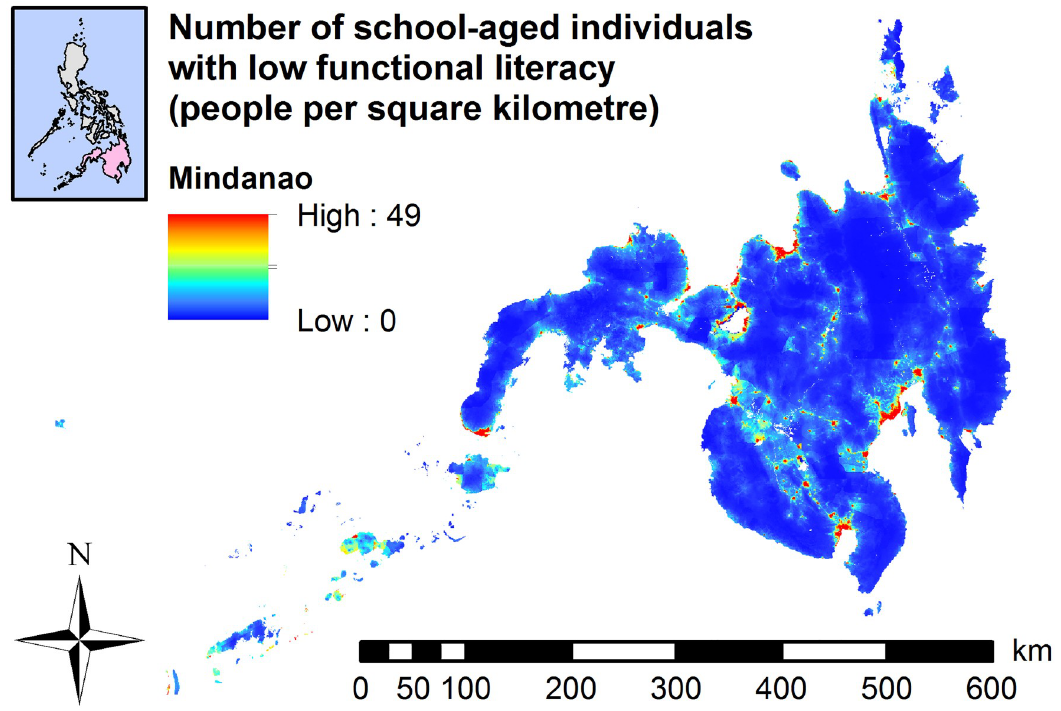
Fig 5. Map showing a total number of school-aged individuals with low functional literacy, 2017, Mindanao, based on Model 6.